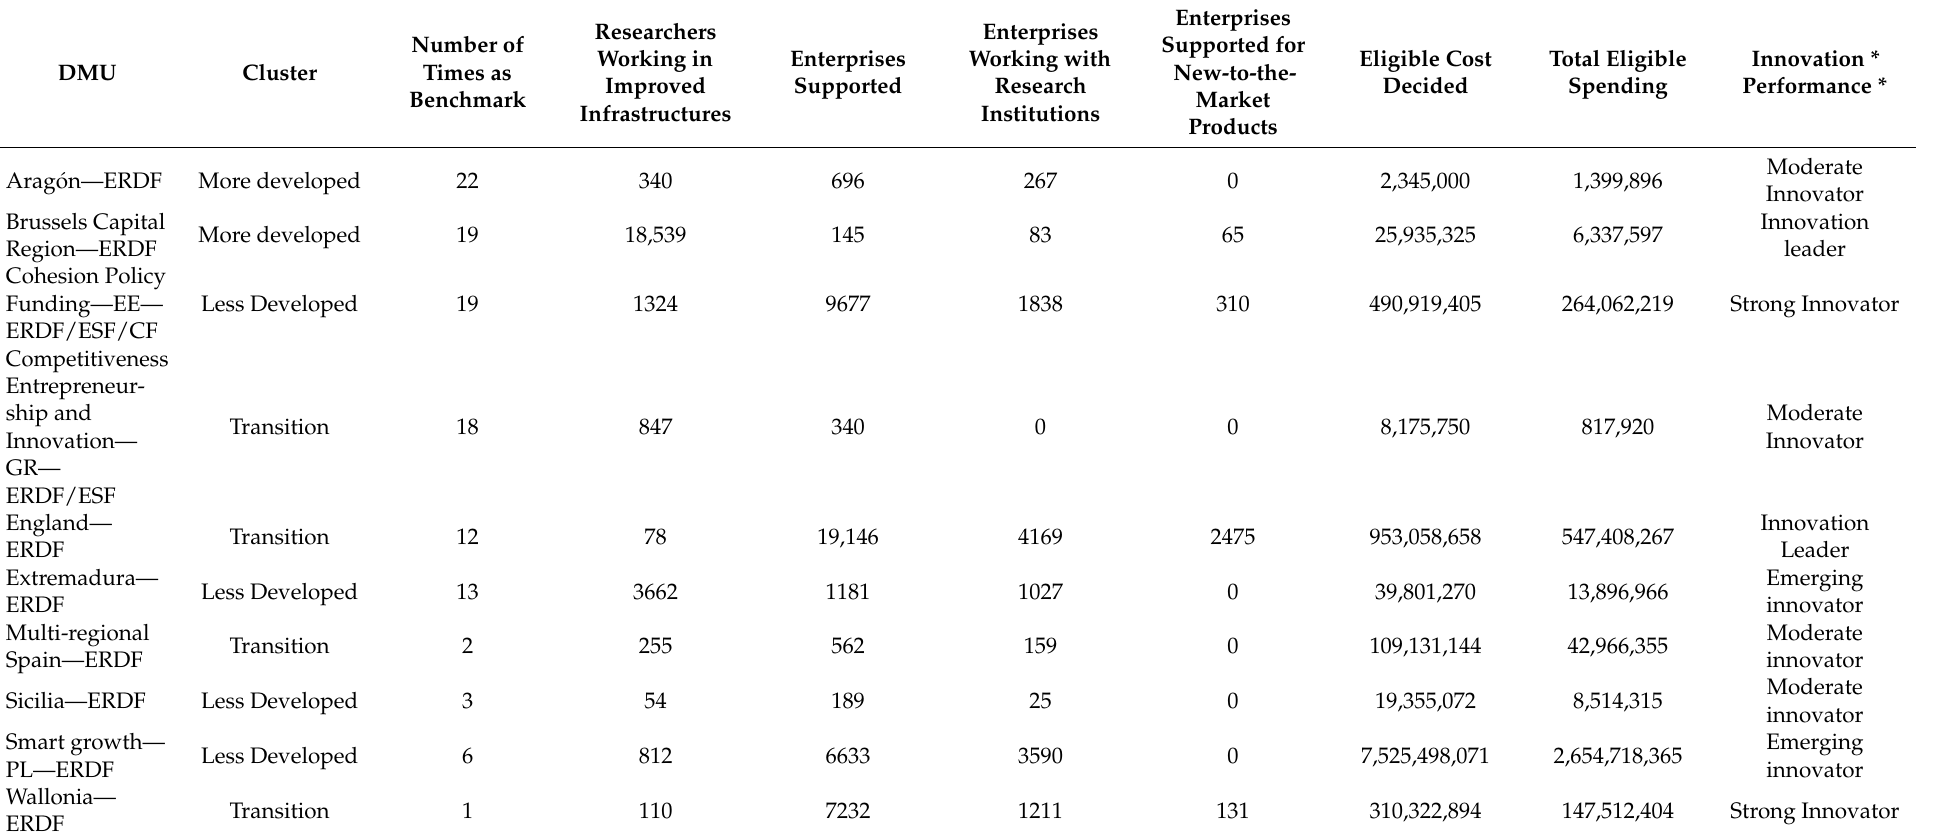
Table 8. Main characteristics of network efficient